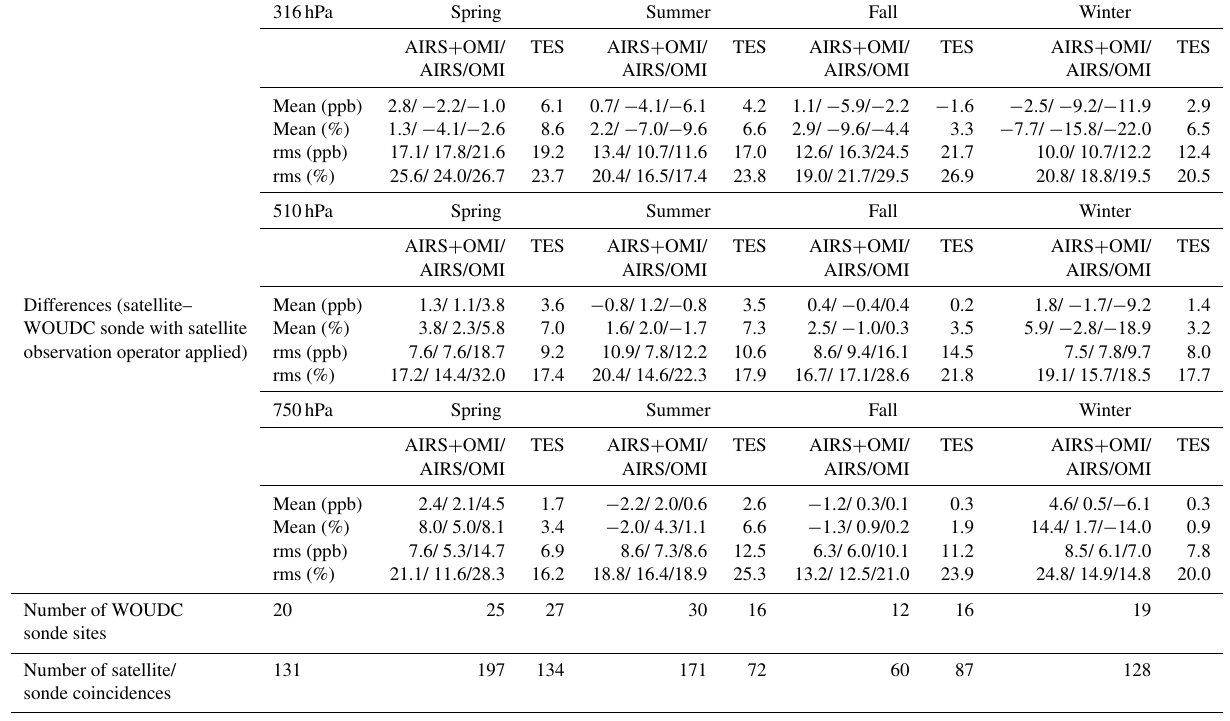
Table 4. Comparisons between satellite remote-sensing and ozonesonde in situ measurements for 2006 at three pressure levels (316, 510, and 750hPa), with satellite observation operators applied to the ozone measurements in order to account for sensitivity.